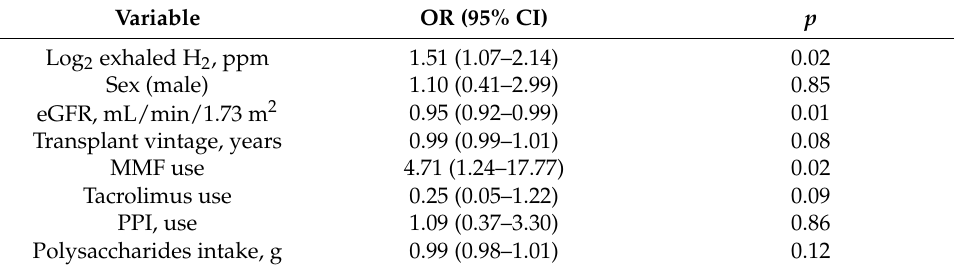
Table 3. Multivariable association between exhaled H 2 and